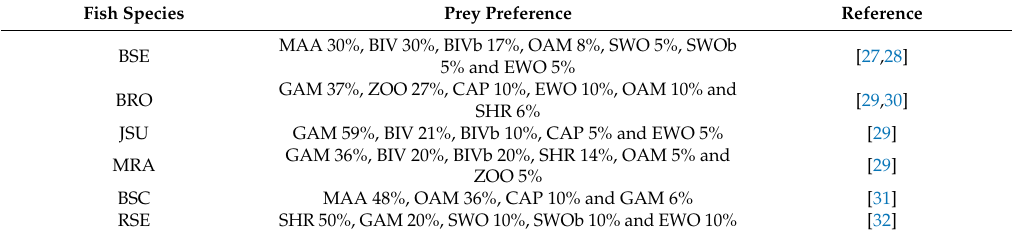
Table 2. Summary of feeding habits of dominant fish species observed in Mitsu Bay, which were incorporated in the